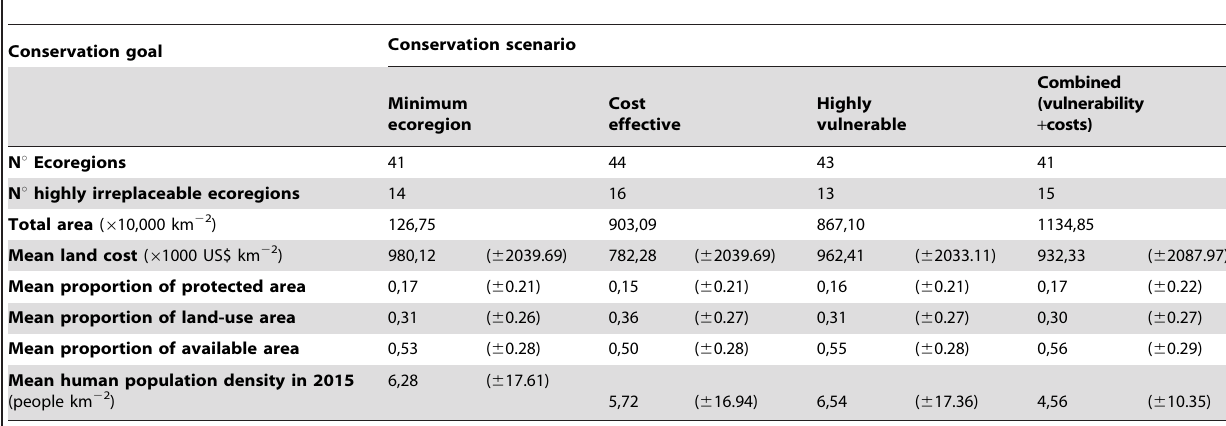
Table 1. Summary results for the four systematic planning scenarios for conservation of the world’s